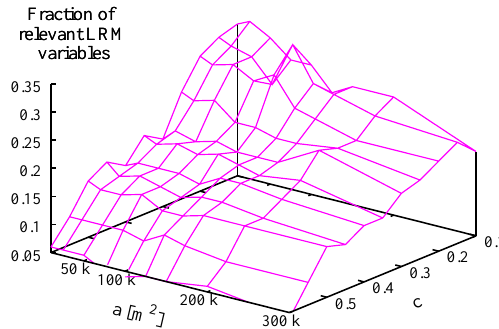
Figure 12. Percentage of relevant variables in the LRM used in this work to prepare the LS maps as a function of the a and c user- defined modeling parameters. Combination of a and c are the same used to prepare Fig. 11. Note that the direction of the axes is re- versed with respect to Fig.